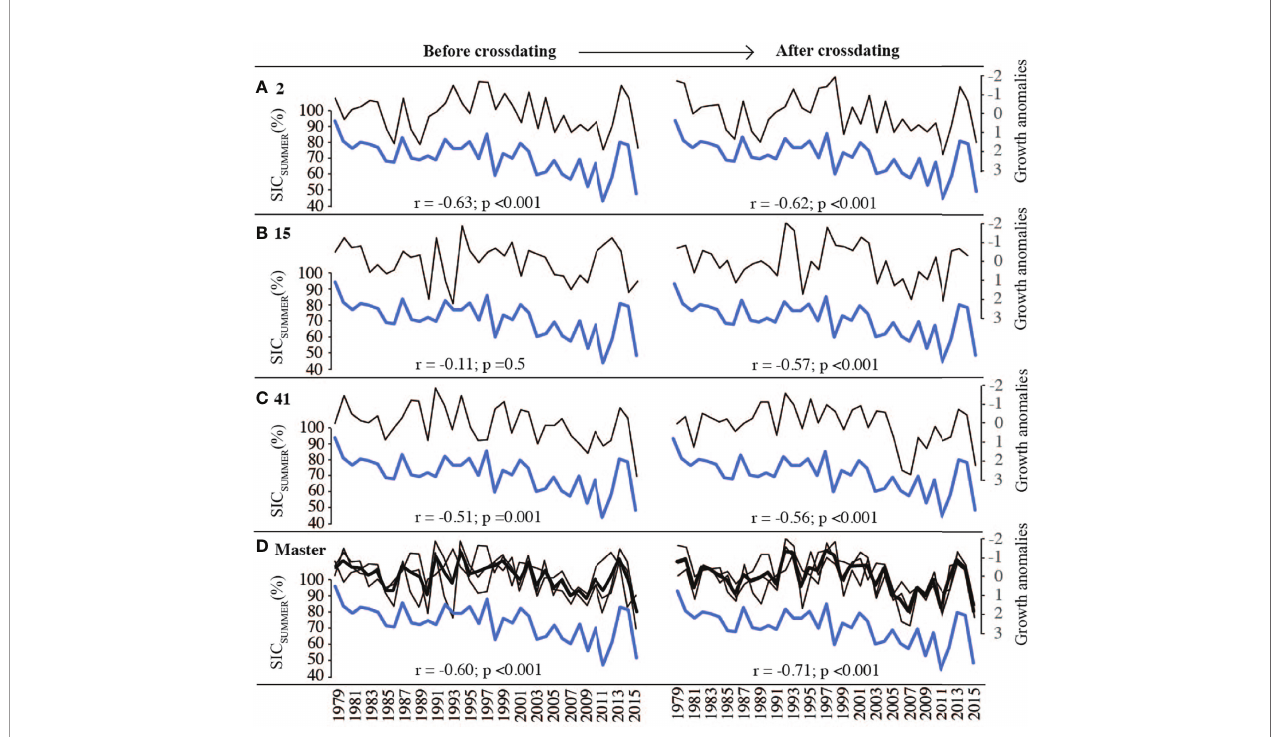
FIGURE 8 | Relationship between regional summer sea ice concentrations (SIC; blue) and standardized algal growth anomalies (averaged transects for each sample; A – C black) before (left) and after (right) crossdating. Growth anomalies inversed on y-axis due to hypothesized negative relationship between growth and sea ice cover. Master chronology of all averaged timeseries presented in black (D) . All correlation coef fi cients between individual timeseries/master chronology and SIC reported as